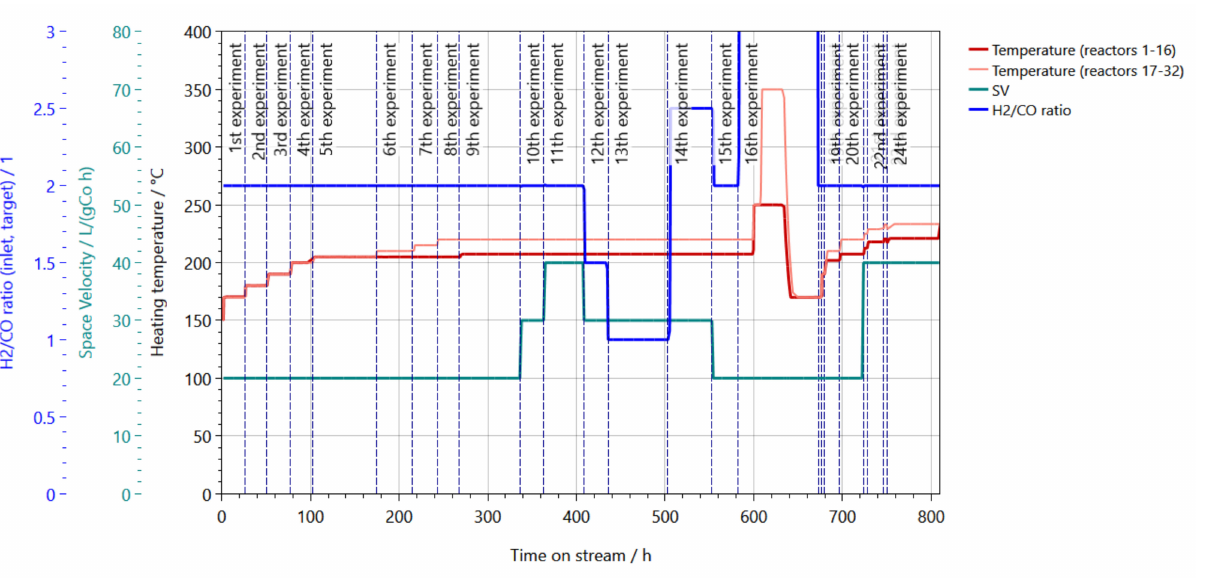
Figure 4. Overview of all applied reaction